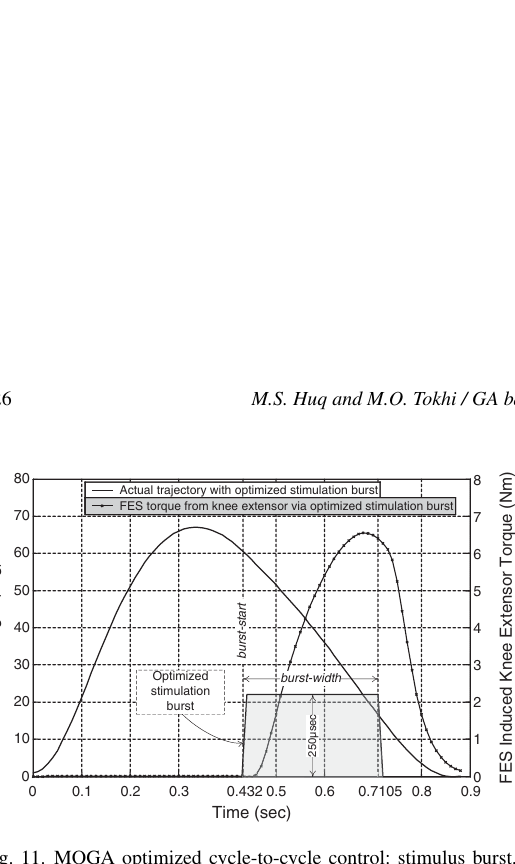
Fig. 11. MOGA optimized cycle-to-cycle control: stimulus burst, FES induced active torque and knee joint trajectory.